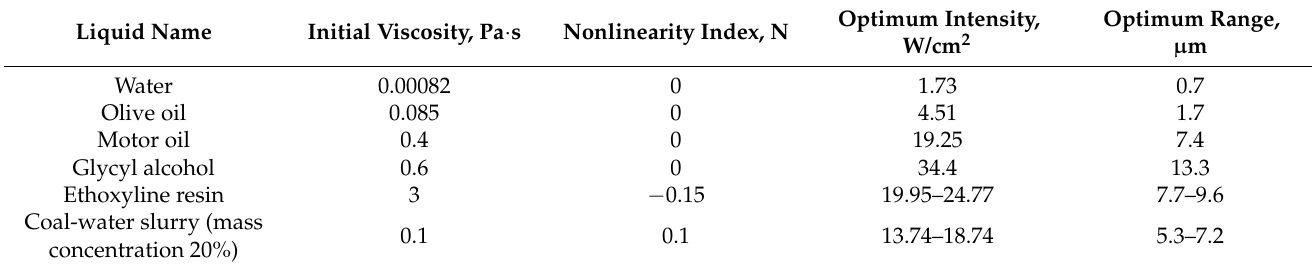
Table 2. Values for optimum degree of impact for liquids used in